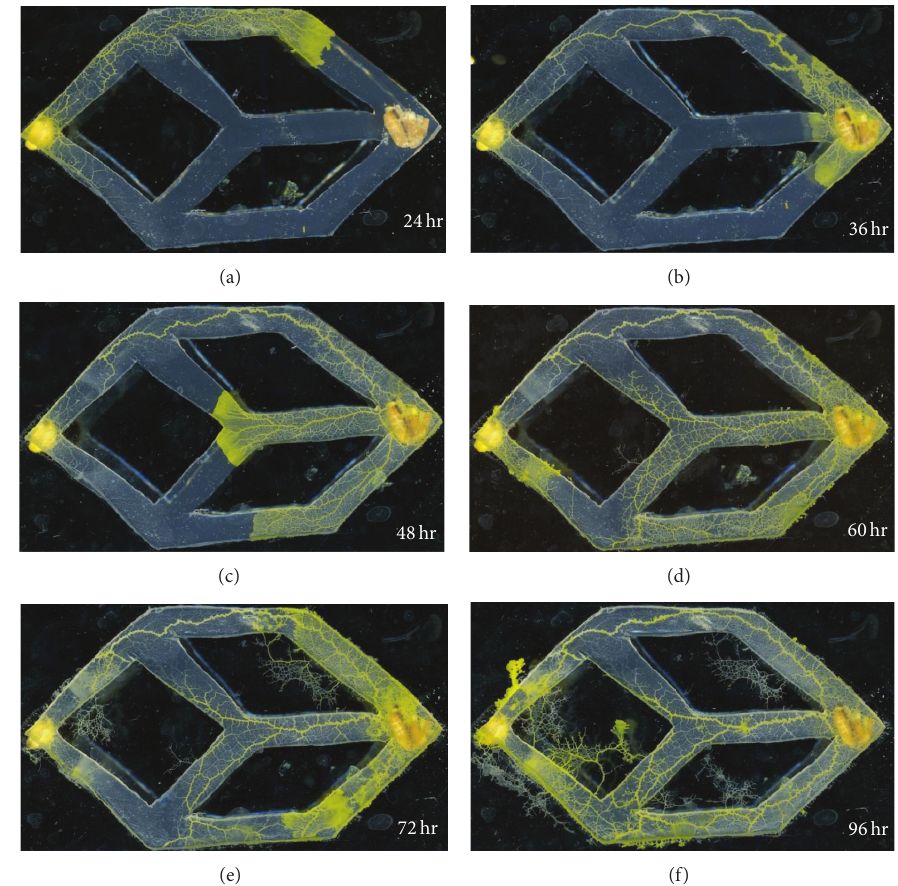
Figure 8: The process of shortest path formulation by real Physarum polycephalum . From (a) to (f) the Physarum polycephalum grew out of the source node and gradually constructed the shortest path from the source node to the ending